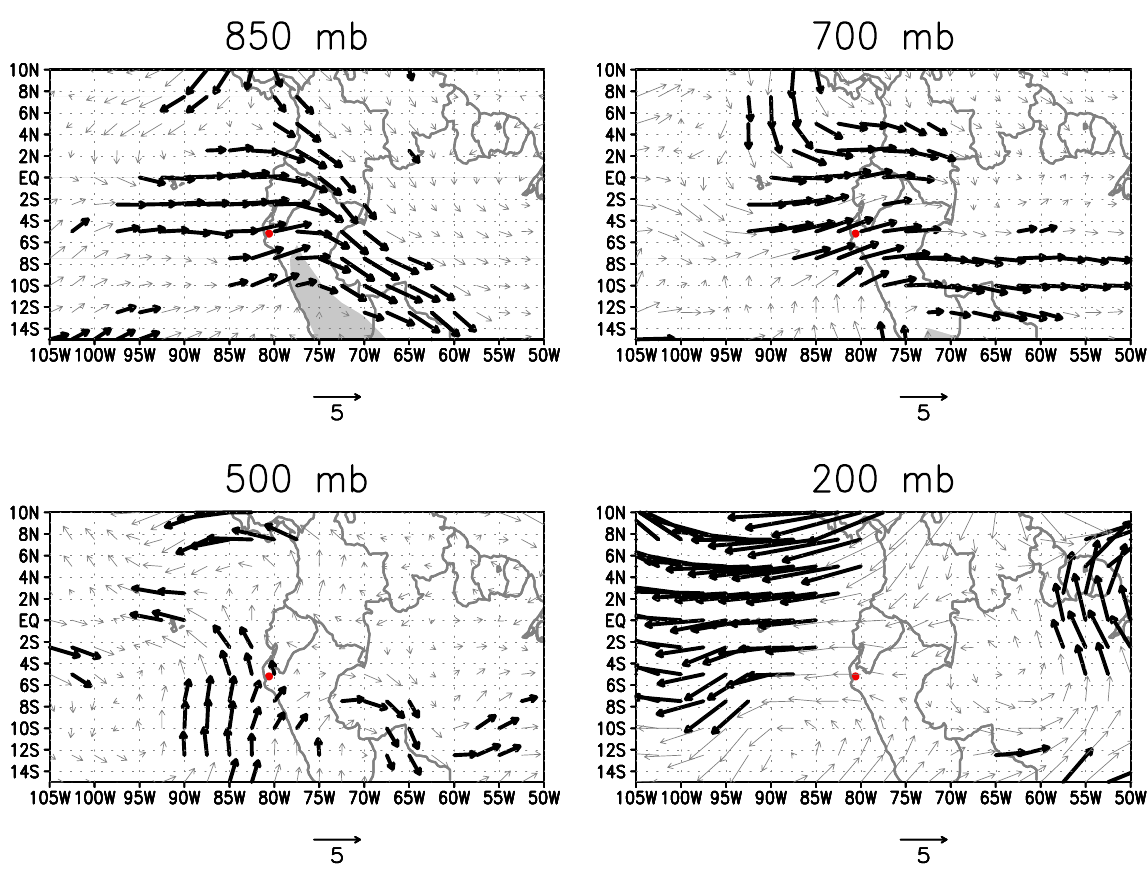
Fig. 10. Differences (rainy days minus dry days) in the composited NCEP/NCAR Reanalysis horizontal winds (ms − 1 ) during December 1997–April 1998 at 850 mb (top-left), 700 mb (top-right), 500 mb (bottom left) and 200 mb (bottom-right). Difference vectors for which at least one of their components pass a Student- t test at the 95% level are thicker. The red dot indicates the approximate position of Piura. Grey shading indicates where the pressure level is higher than the mean surface